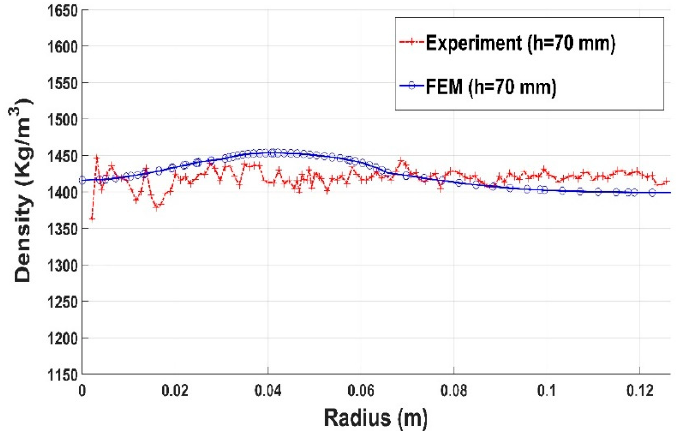
Figure 32. Density profile along the radius (slot): experiment vs. finite element result (h = 70 mm).